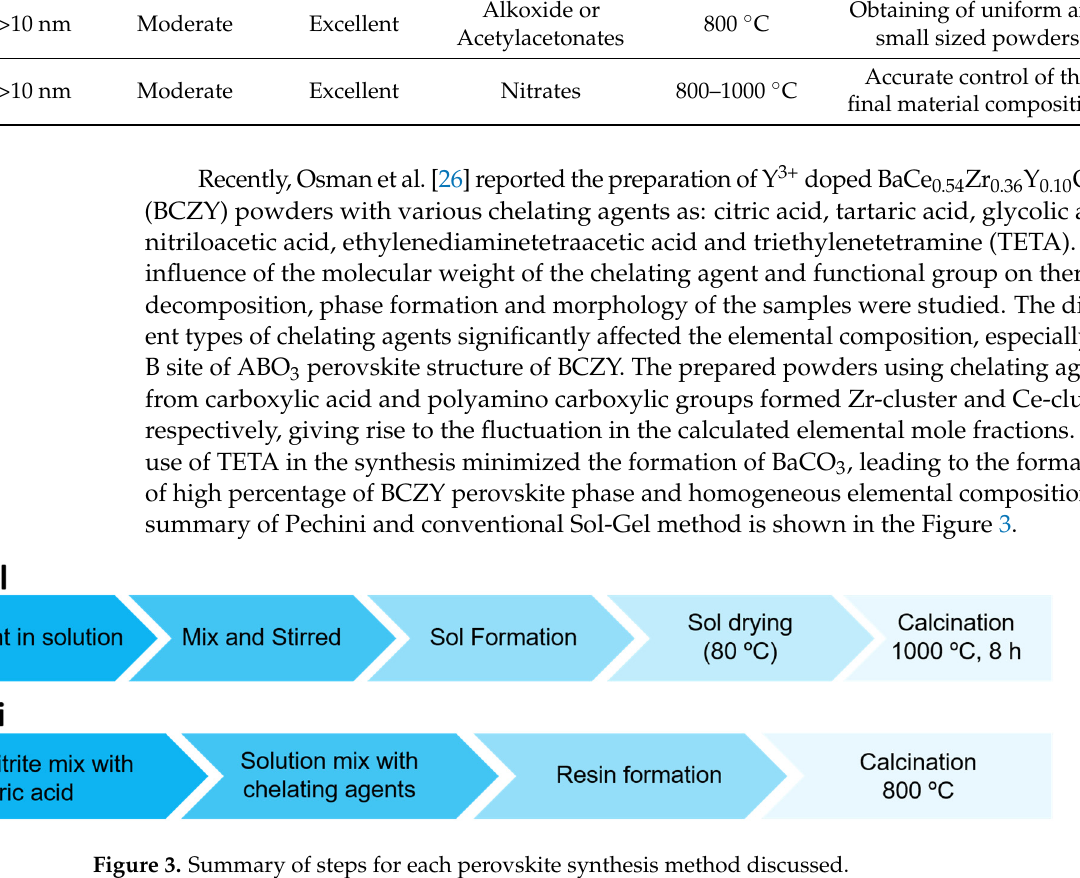
Table 1. Main characteristic of methods for synthesis by Sol-Gel.